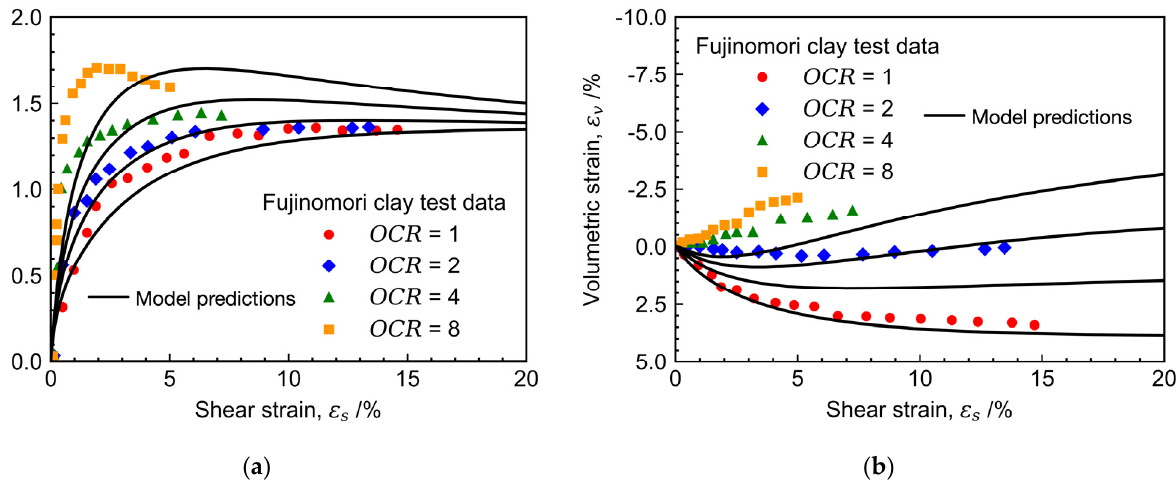
Figure 10. Measured and predicted drained triaxial test results of Fujinomori clay: ( a ) the stress ratio–axial strain relation; ( b ) the volumetric strain–axial strain